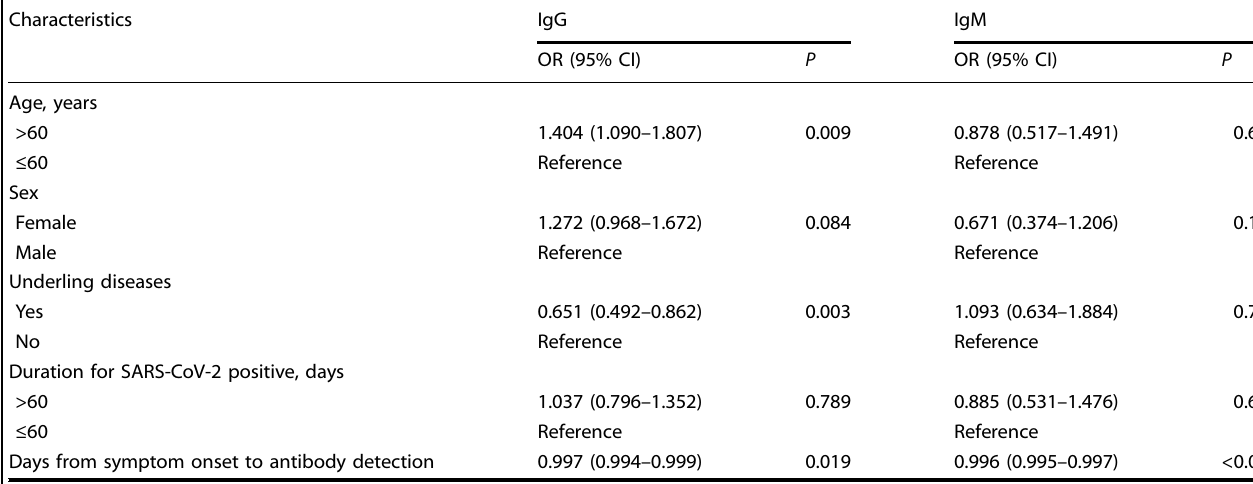
Table 3. Multivariate analysis on the factors related to the IgG/IgM antibody levels of the patients with persistent SARS-CoV-2 infection Characteristics